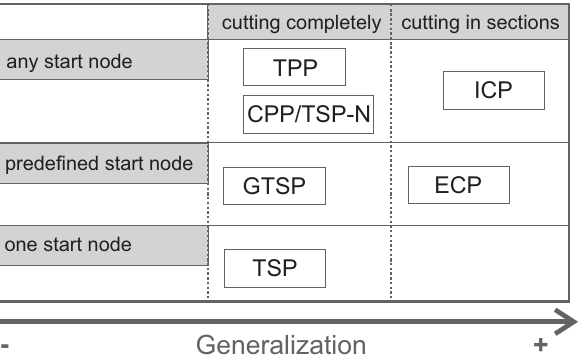
Figure 2. Classification for cutting path problems according to [18,20,25]. TPP: touring polygons problem; CCP: continuous cutting problem; TSP: traveling salesman problem; TSP-N: TSP with neigh- borhoods; ICP: intermittent cutting problem; GTSP: generalized TSP; ECP: endpoint cutting